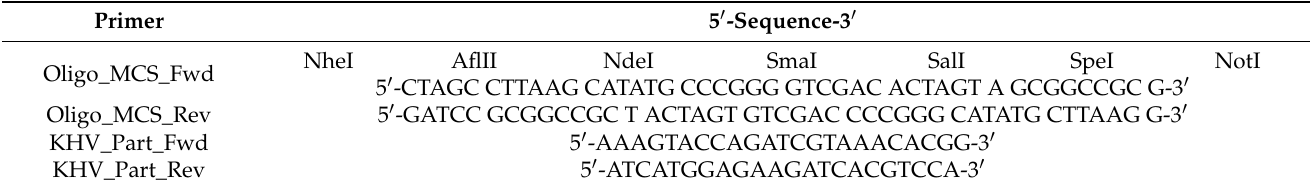
Table 1. Primer sequence for pCTCON-KHV cloning and